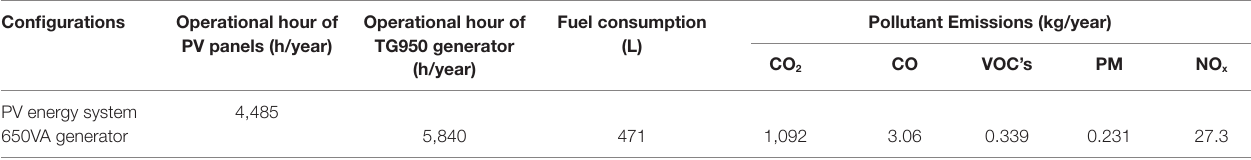
TaBle 7 | simulation results of operational hour, fuel consumption, and pollutant emissions of power